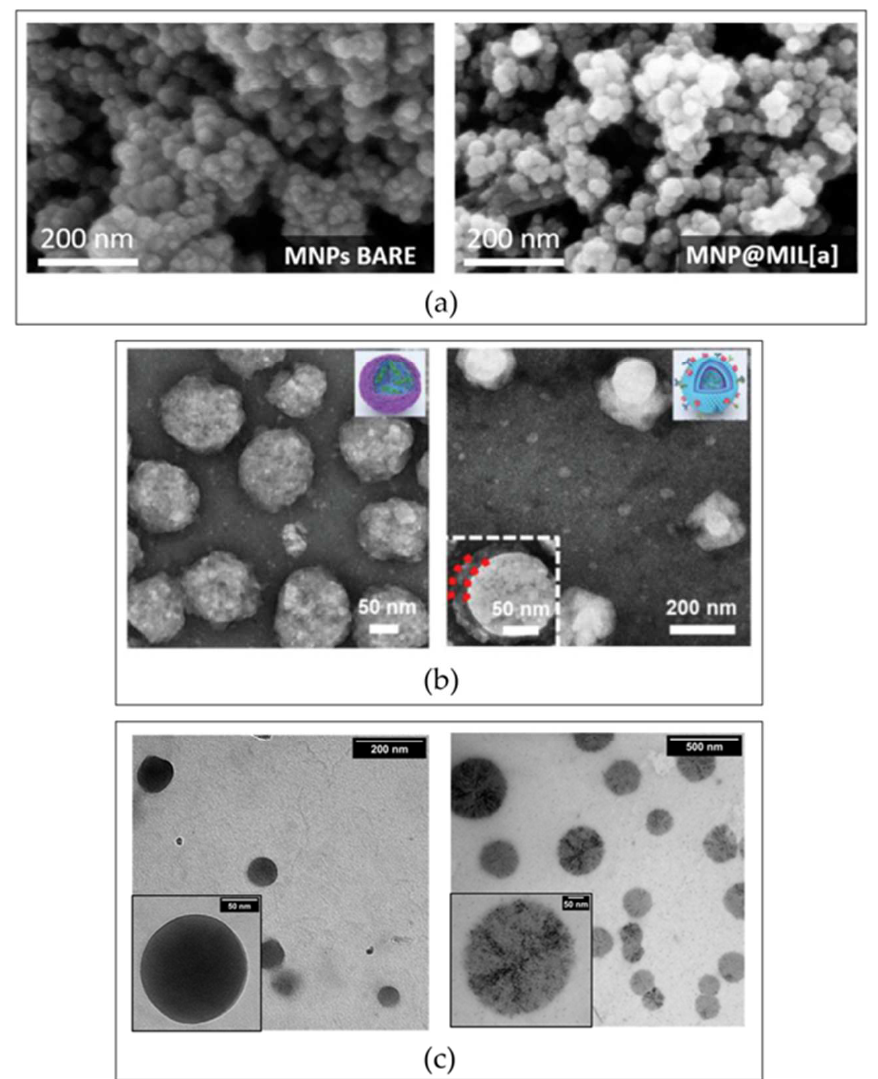
Figure 3. Morphological characterization of surface-modified NPs. ( a ) Fe 3 O 4 magnetic NPs covered with a metal–organic framework. SEM images of bare ( left ) and decorated ( right ) NPs. Adapted with permission from Pulvirenti et al. [143] (IJMS, MDPI, 2022). ( b ) TEM analysis of biomimetic NPs made up of siRNA complexed polyethyleneimine xanthate before ( left ) and after the cell membrane coating ( right ). Adapted with permission from Zhang et al. [154] (Adv. Funct. Mater., Wiley, 2022). ( c ) TEM images of hyaluronic acid NPs pre ( left ) and post ( right ) modification with Angiopep-2. Adapted with permission from Costagliola di Polidoro et al. [155] (Cancers, MDPI, 2021). Abbreviations: NPs—nanoparticles; SEM—scanning electron microscopy; TEM—transmission electron